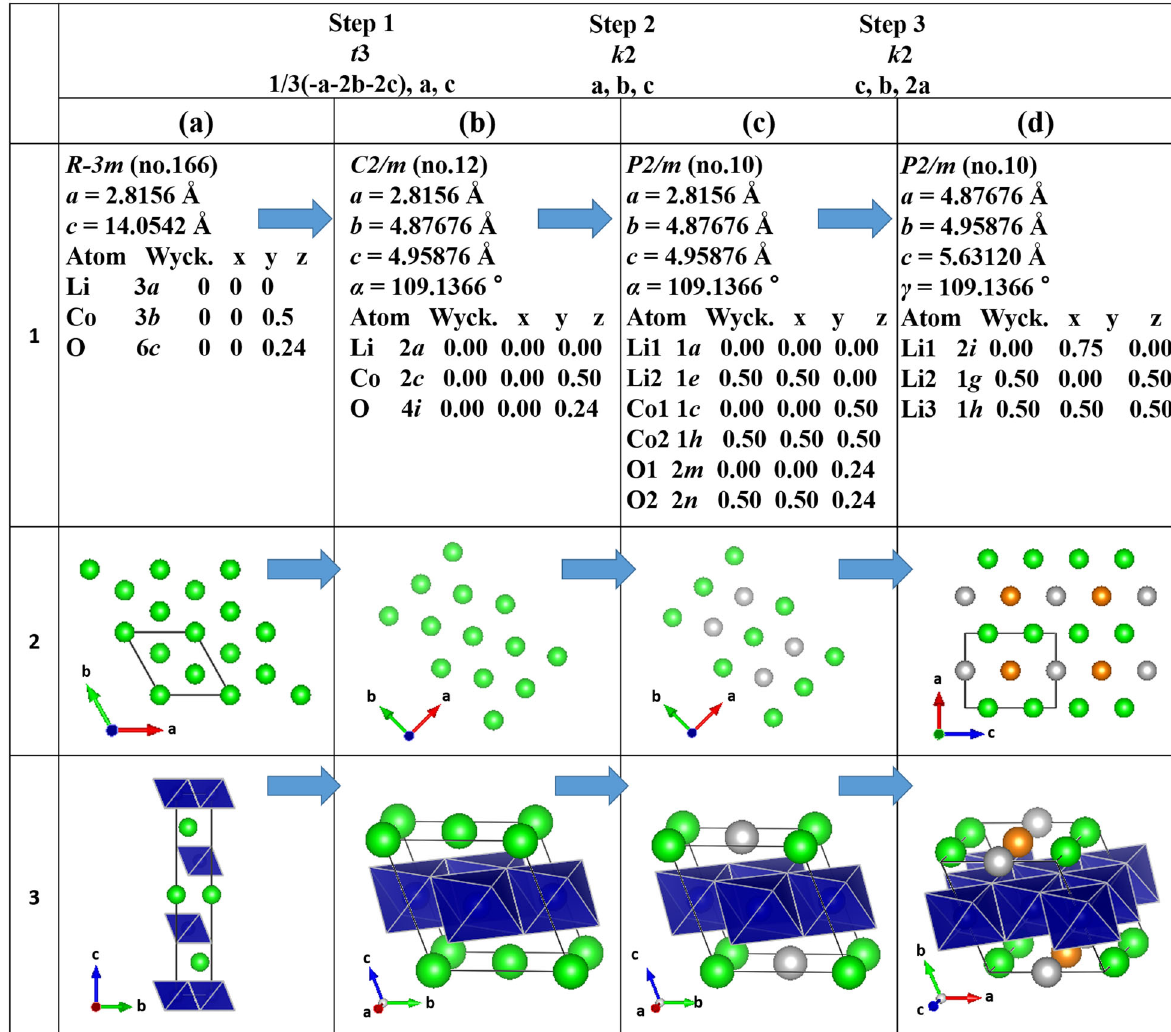
Fig. 3 Phase transitions from LiCoO 2 to Li 0.75 CoO 2 . a LiCoO 2 ( R-3m ). b Obtaining C2/m by loss of -3 symmetry operation. c Obtaining P2/m by loss of centering. d Isomorphic enlargement of P2/m with an index of 2. All the structures are converted to the reduced cells. The blue octahedron represents the CoO 6